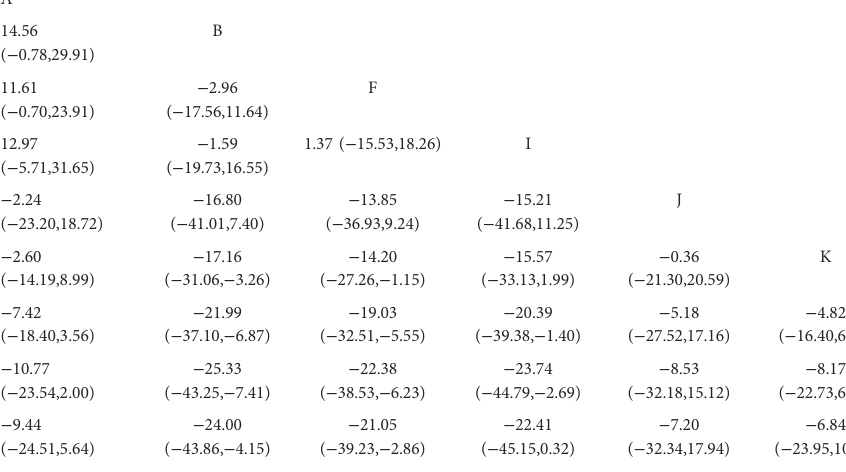
TABLE 3 Network meta-analysis results of VAS scores (RR, 95% CI).